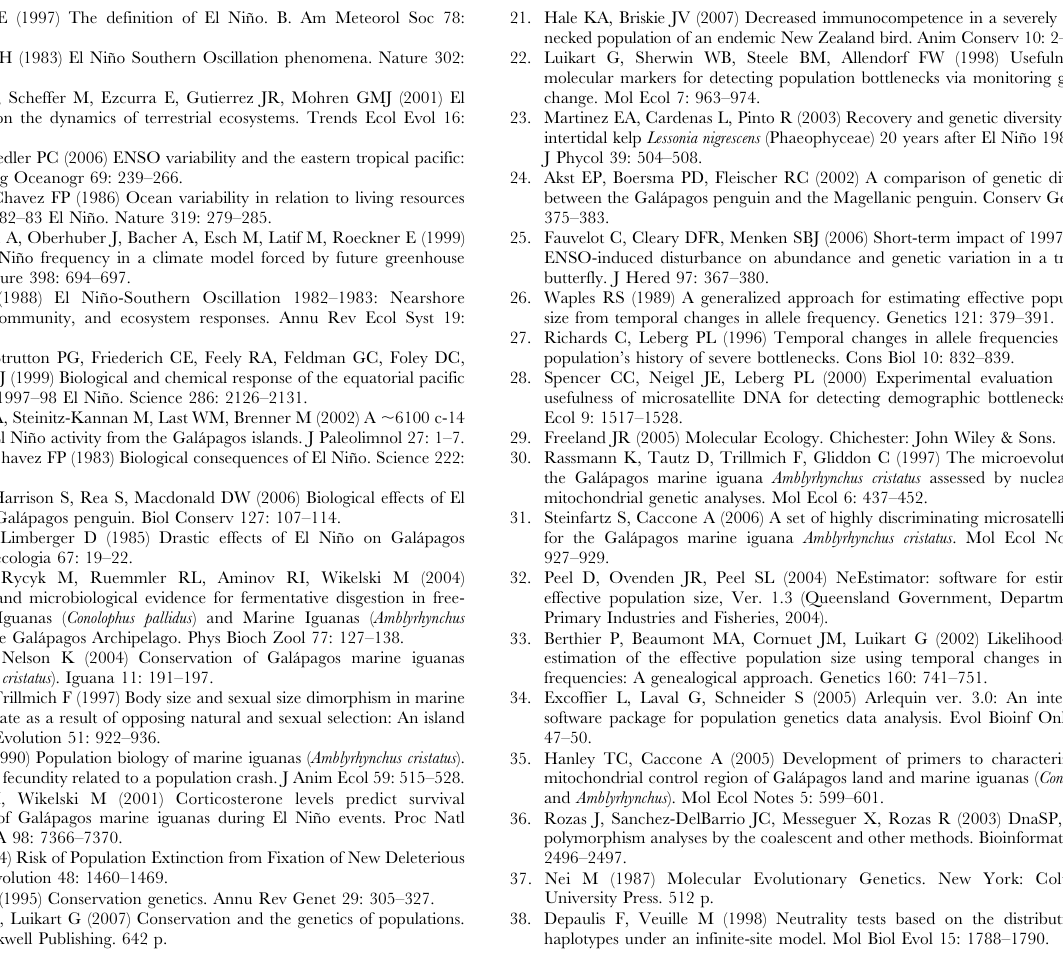
populations from both time points. T-values and their corre- sponding probabilities are based on the test adapted by Nei [37] and reflect whether Hd values are significantly different between time points. Positive t values reflect a decrease Hd from the first to second sampling, while negative t values reflect an increase.